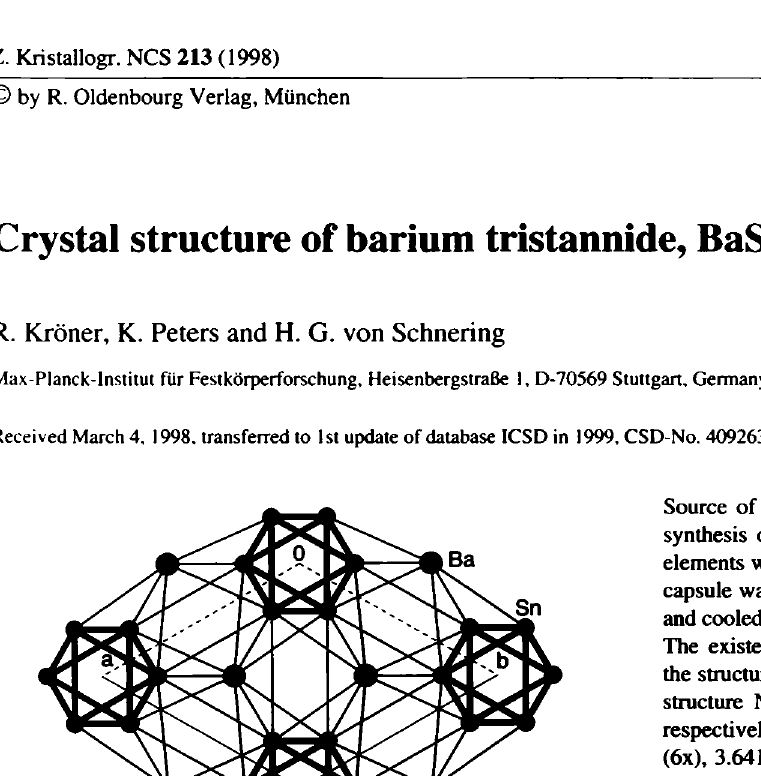
Table 1. Parameters used for the X-ray data collection Crystal: